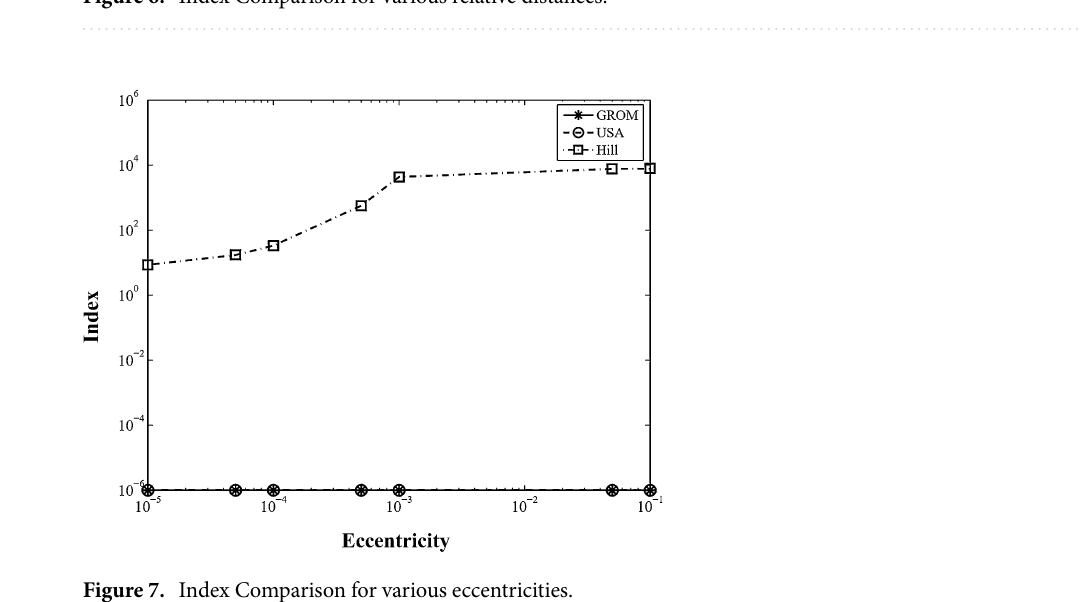
Figure 6. Index Comparison for various relative distances.